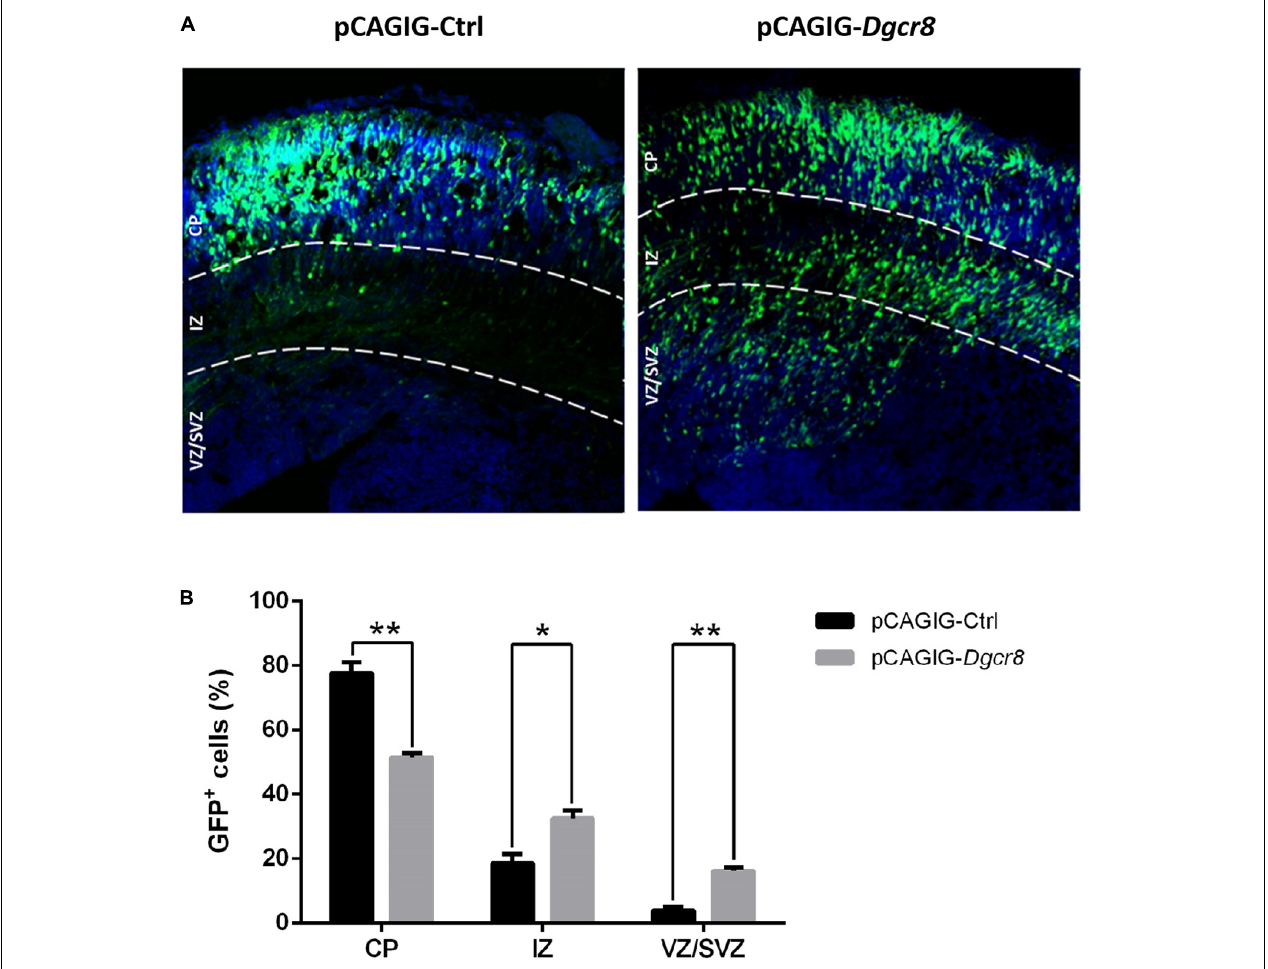
FIGURE 5 | Overexpression of Dgcr8 in ceretral cortex at E13.5 delayed neural migration. Transfected cells expressed GFP, and sections were divided into three zones according DAPI staining (Blue), including VZ/SVZ (ventricular zone/subventricular zone), IZ (intermediate zone), and CP (cortical plate). At 16.5, the amount of GFP + cells in every zone was counted and analyzed. Datas are presented as means ± SEM. Two-way ANOVA test. * p < 0.05; ** p <